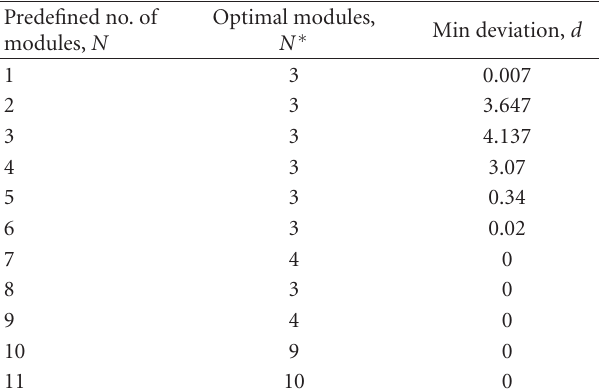
Table 5: E ff ect of N on optimal modules, N ∗ and min deviation, d —stakeholder 2